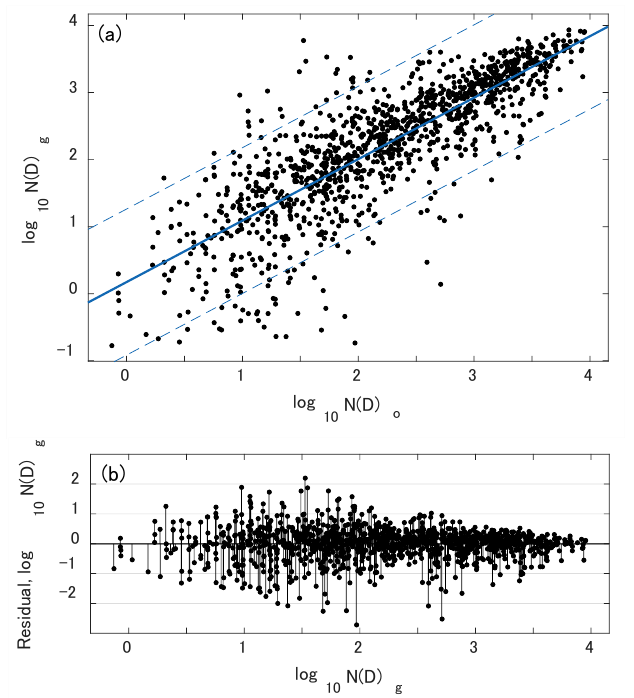
Figure 16. ( a ) Comparison of the gamma PSD model and observed PSDs. The solid line represents the regression line, and the dashed lines are 95% confidence limits. ( b ) The residual of gamma N ( D ) expressed on a logarithmic scale. The subscripts ‘g’ and ‘o’ in the variables mean the gamma PSD model and observed PSD,